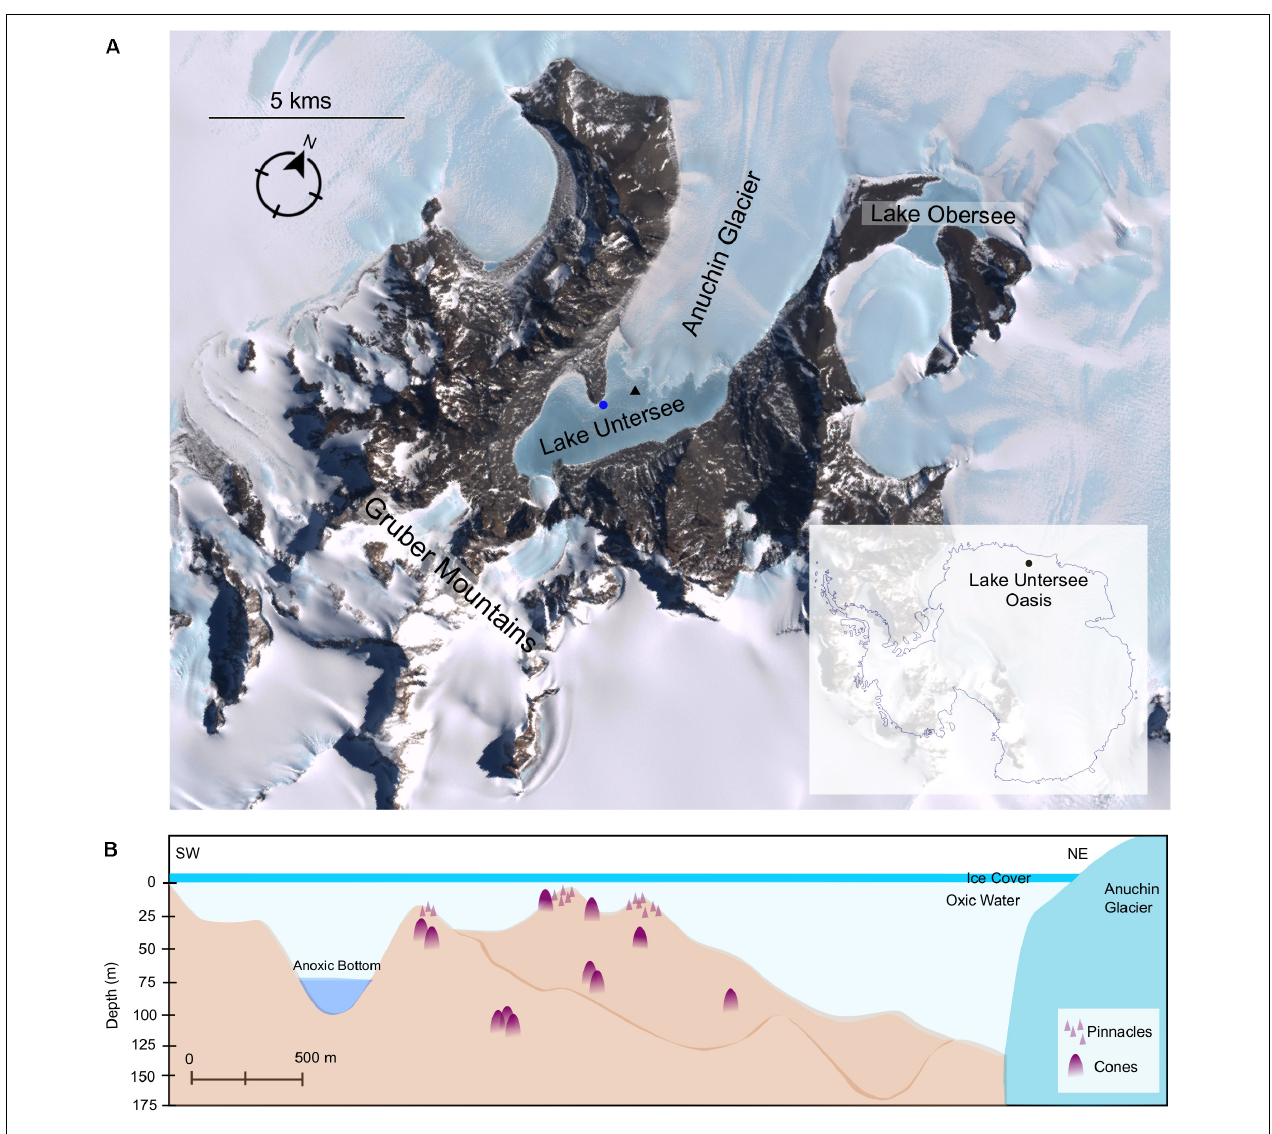
FIGURE 1 | (A) Satellite imagery of Lake Untersee Oases. Image capture by Landsat 7 satellite (download via LIMA database from United States Geographical Survey). Benthic sampling and water profiling sites are denoted by a blue circle and black triangle, respectively. (B) Schematic illustration of Lake Untersee based on Wand et al. (2006) and (Faucher et al., 2019). Representative symbols for pinnacles and cones as shown in Figure 2 , which are not to scale.